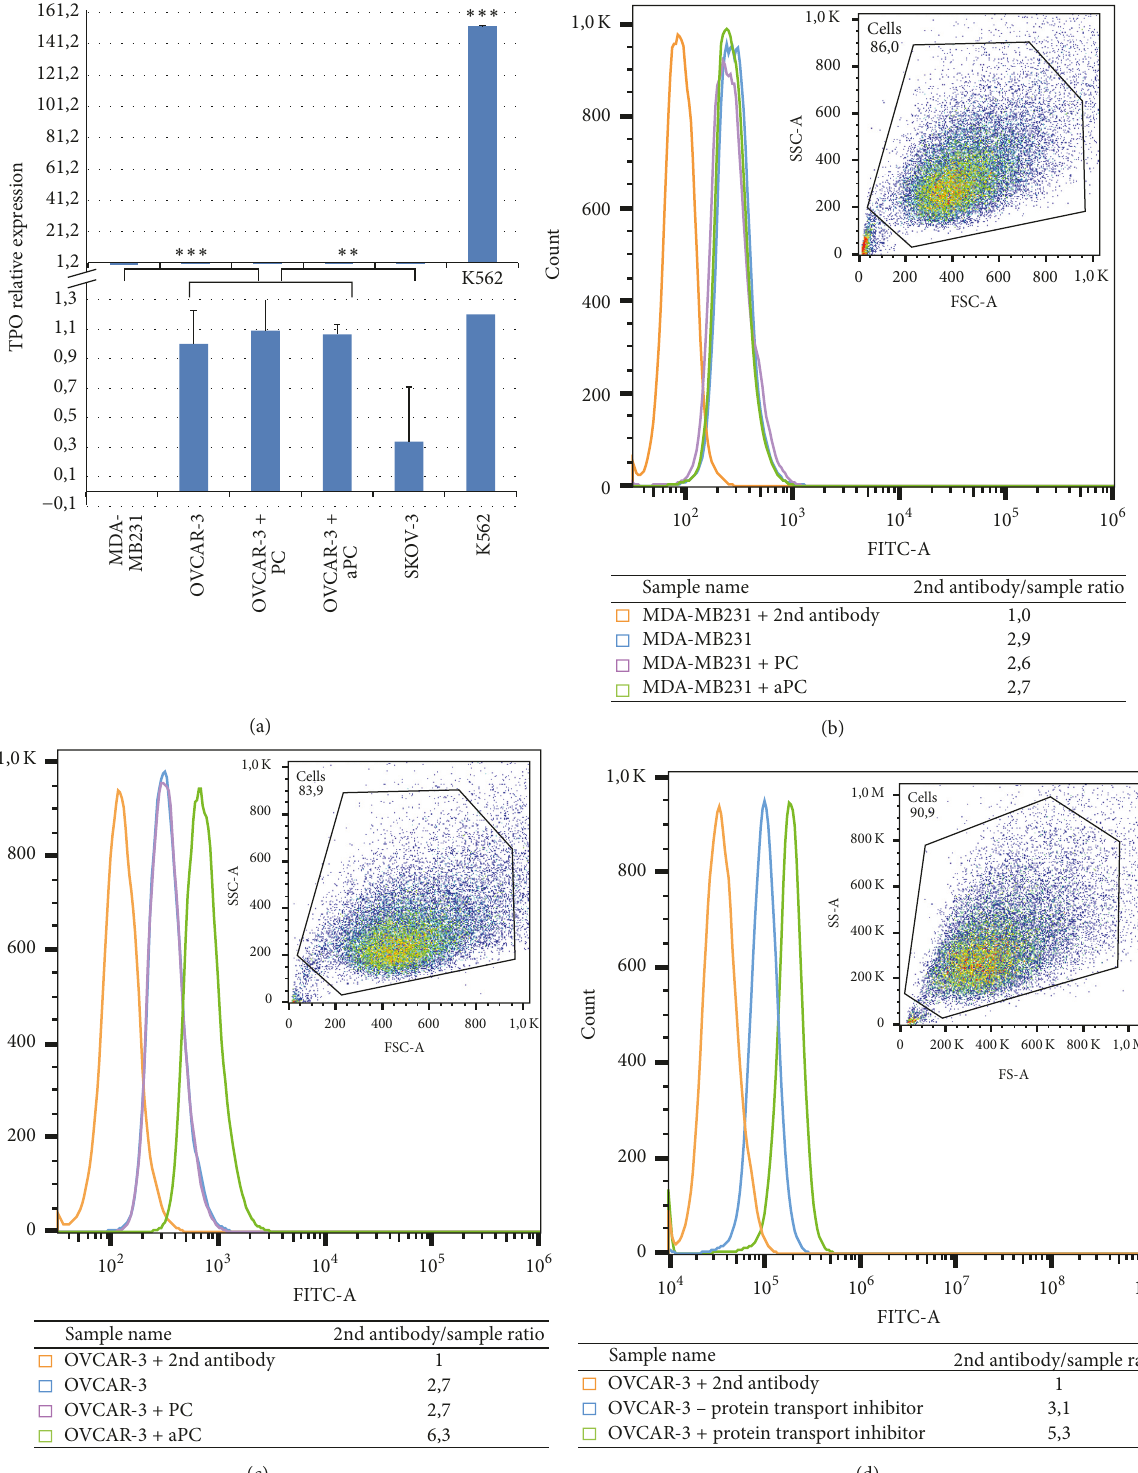
Figure 5: TPO gene expression in the presence or absence of protein C. (a) Quantification of TPO gene expression using TaqMan Probes in different cancer cell lines such as MDA-MB231 (as control), OVCAR-3, SKOV-3, and K562. Nonsignificant results were observed in the presence of protein C ( 𝑃 < 0 , 05 ). High TPO gene expression was observed in leukemic K562 cell. Kruskal-Wallis test ( ∗∗ 𝑃 < 0 , 02 , ∗∗∗ 𝑃 < 0 , 01 ). Flow cytometry distribution plots are shown. Graphs represent Geometric Fluorescence Mean. (b, c): graphs for MDA-MB231 (b) and OVCAR-3 (c) cells incubated with the secondary antibody alone (orange), labeled with primary and secondary antibodies after incubation without PC or aPC (blue), and with PC (purple) or with aPC (green). (d) TPO-released protein by OVCAR-3. OVCAR-3 were incubated (for 5 hours) without (blue) or with (green) protein transport inhibitor or with only 2nd antibody as control (orange). 2nd antibody GMFI/GMFI sample ratio was calculated for each